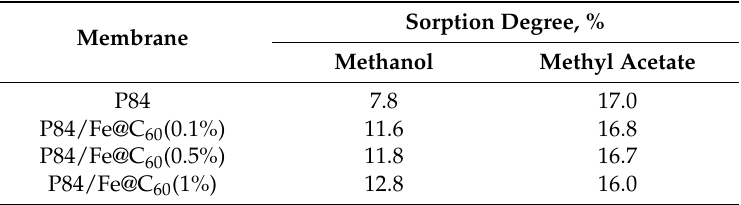
Table 4. Sorption degree of membranes.